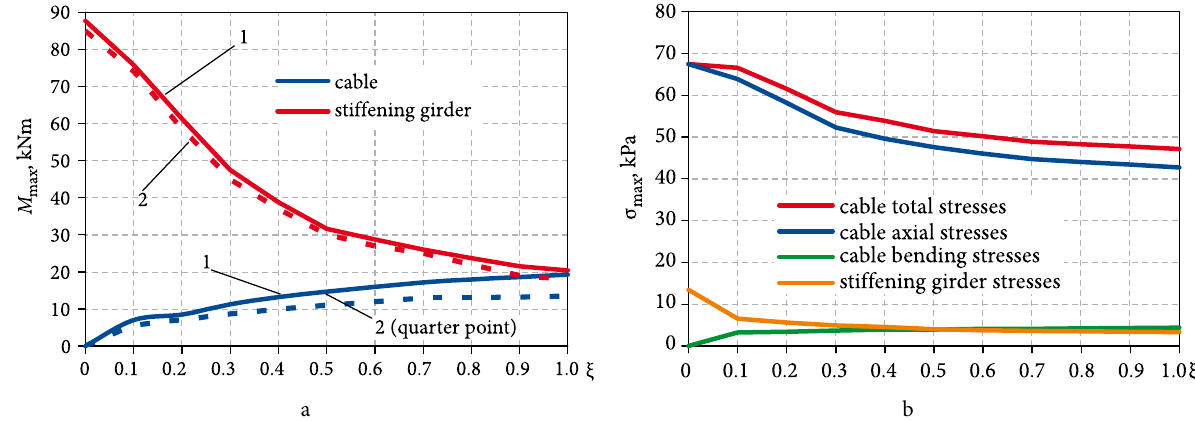
a b Fig. 4. Max moments (a) and stresses (b) in the midspan of the stiffening girder and cable under symmetrical loading (γ = 1): 1 − two-hinged cable; 2 − three-hinged